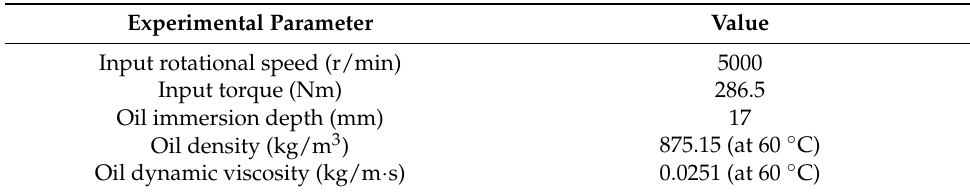
Table 3. Experimental parameters.